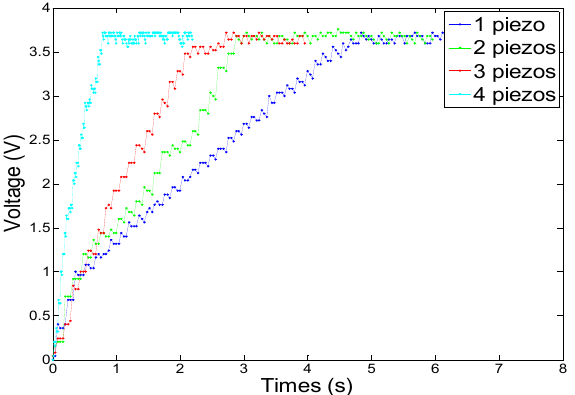
Table 2. Comparison of individual and coupled